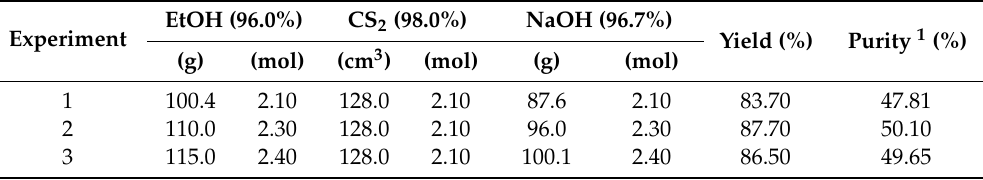
Table 3. Dependence of the Na-EtX yield from the reactant ratio (reaction conditions: reaction time 4.5 h; temperature: I reaction step–65 ◦ C, II reaction step–35 ◦ C.